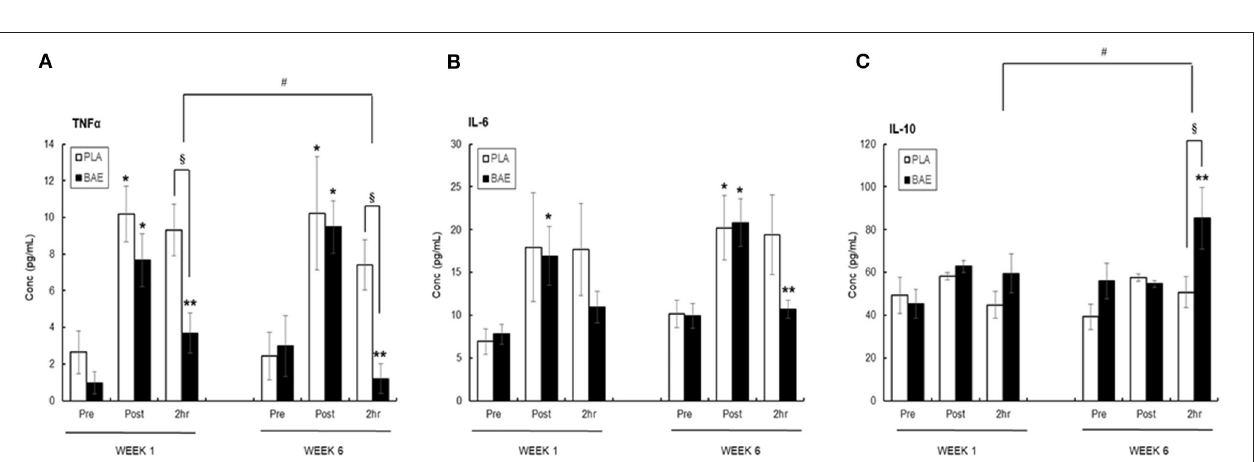
FIGURE 4 | The effect of blackcurrant anthocyanin-rich extract (BAE) or placebo (PLA) consumption 1h prior to exercise on plasma (A) TNF α , (B) IL-6, and (C) IL-10 on week 1 and 6 after 5 weeks of daily consumption. Results are mean ± SEM, n = 18 individuals per nutritional group. * p < 0.05 represents statistical significance from corresponding pre-exercise values. ** p < 0.05 represents statistical difference from corresponding post-exercise values. § p < 0.05 represents statistical difference between PLA and BAE. # p < 0.05 represents statistical difference between corresponding week 1 and 6